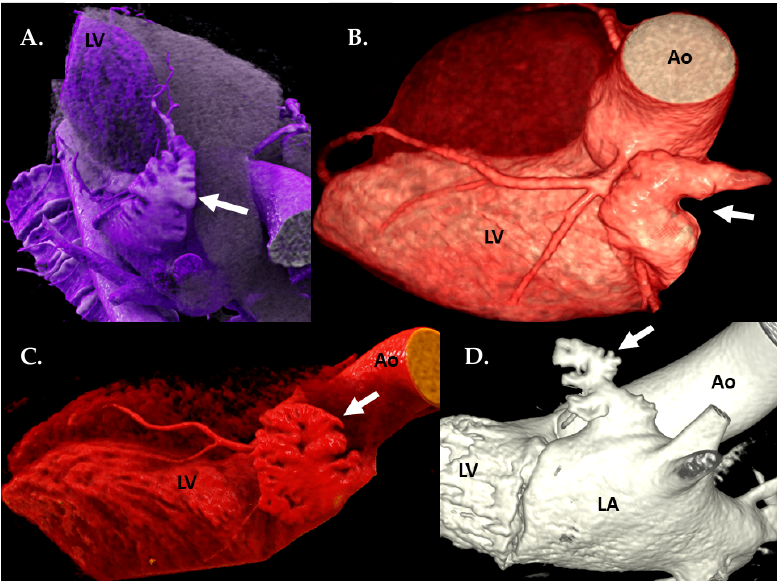
Figure 1. Computed tomography angiography (CTA): 3D volume rendering technique (VRT) reconstructions of the 4 LAA types (white arrows): ( A ) cactus, ( B ) chicken-wing, ( C ) cauliflower, ( D ) windsock. Ao—ascending aorta, LA—left atrium, LV—left ventricle.